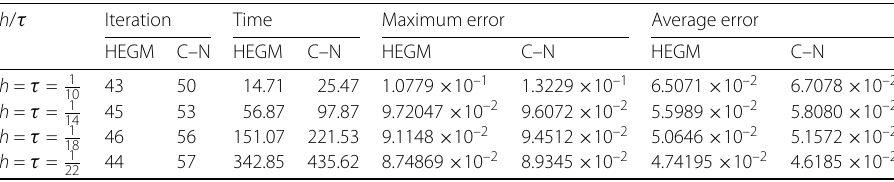
Table 7 Errors and CPU time with τ = 1